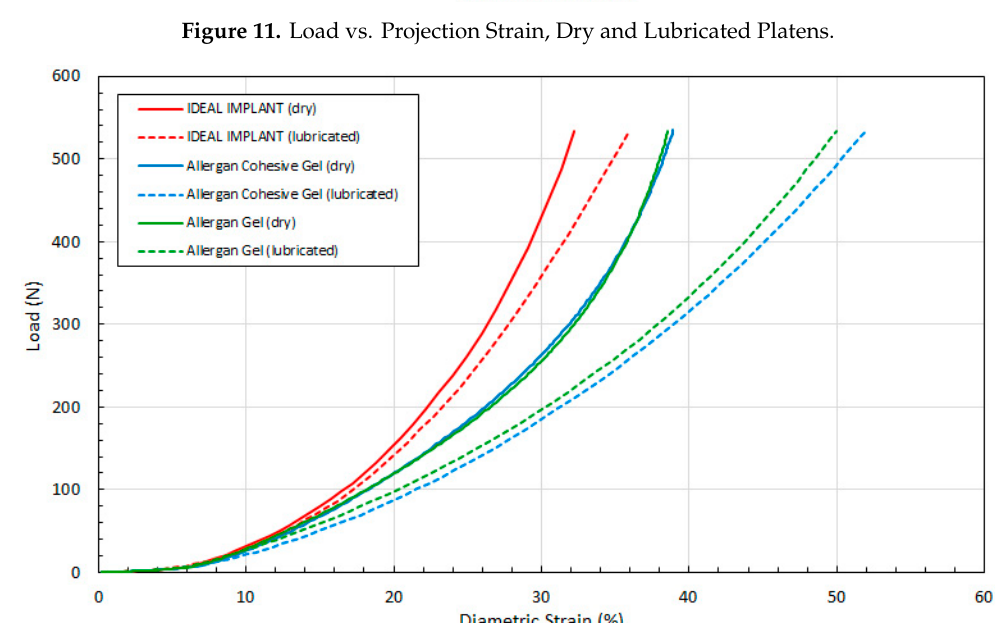
Figure 12. Load vs. Diametric Strain, Dry and Lubricated Platens.